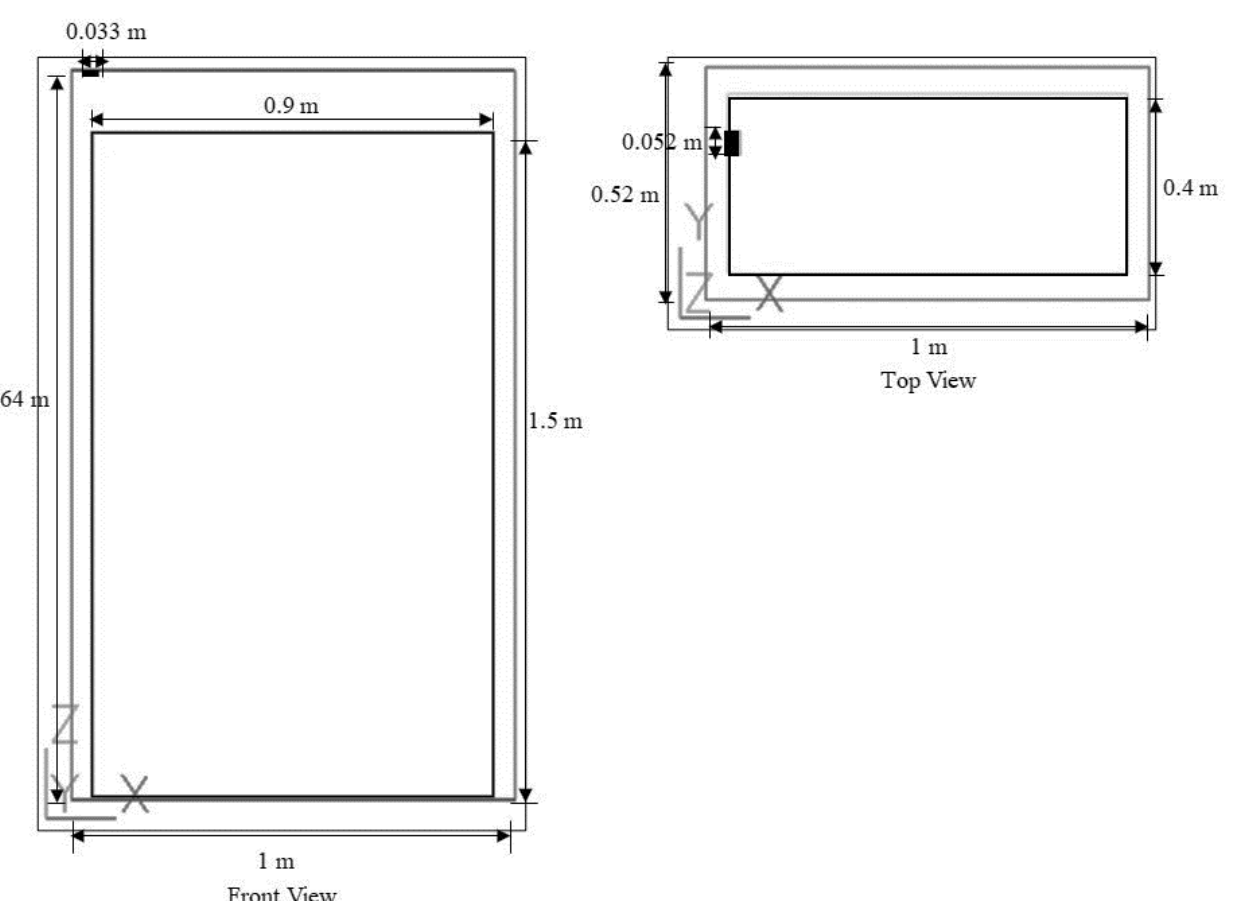
represents the fan).